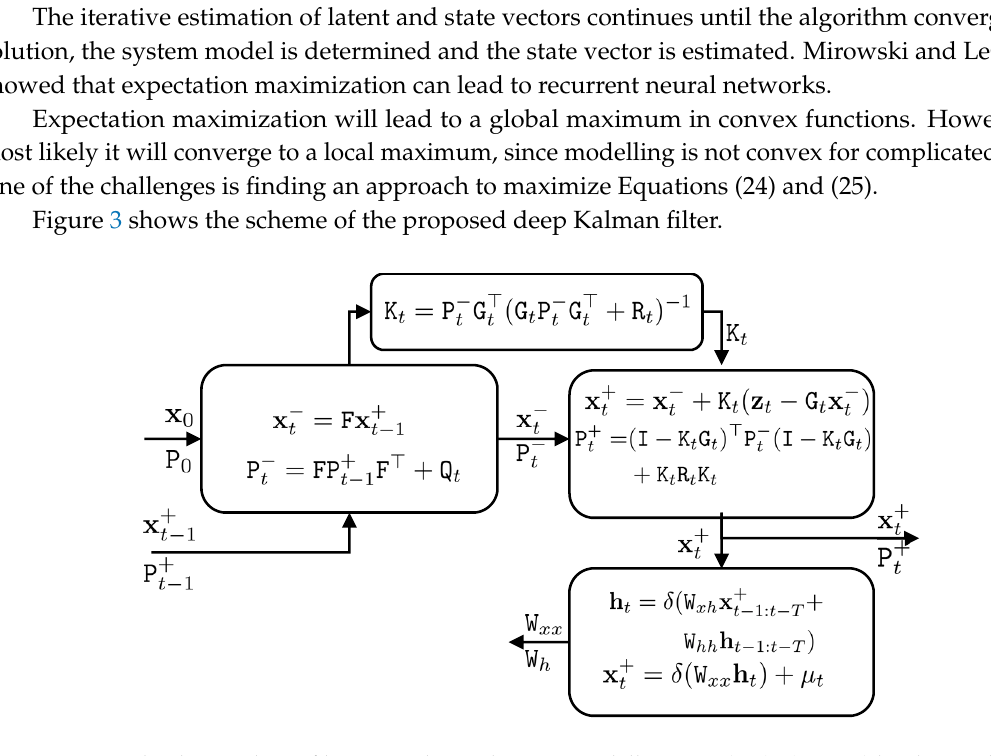
Figure 3. The deep Kalman filter procedure. The IMU modelling step ( right-bottom ) has been added to the Kalman filter. The modelling is accomplished in two steps: in the first step, the current latent vector is estimated based on previous latent and state vectors; and in the second step, the current state vector is estimated based on the current latent vector.